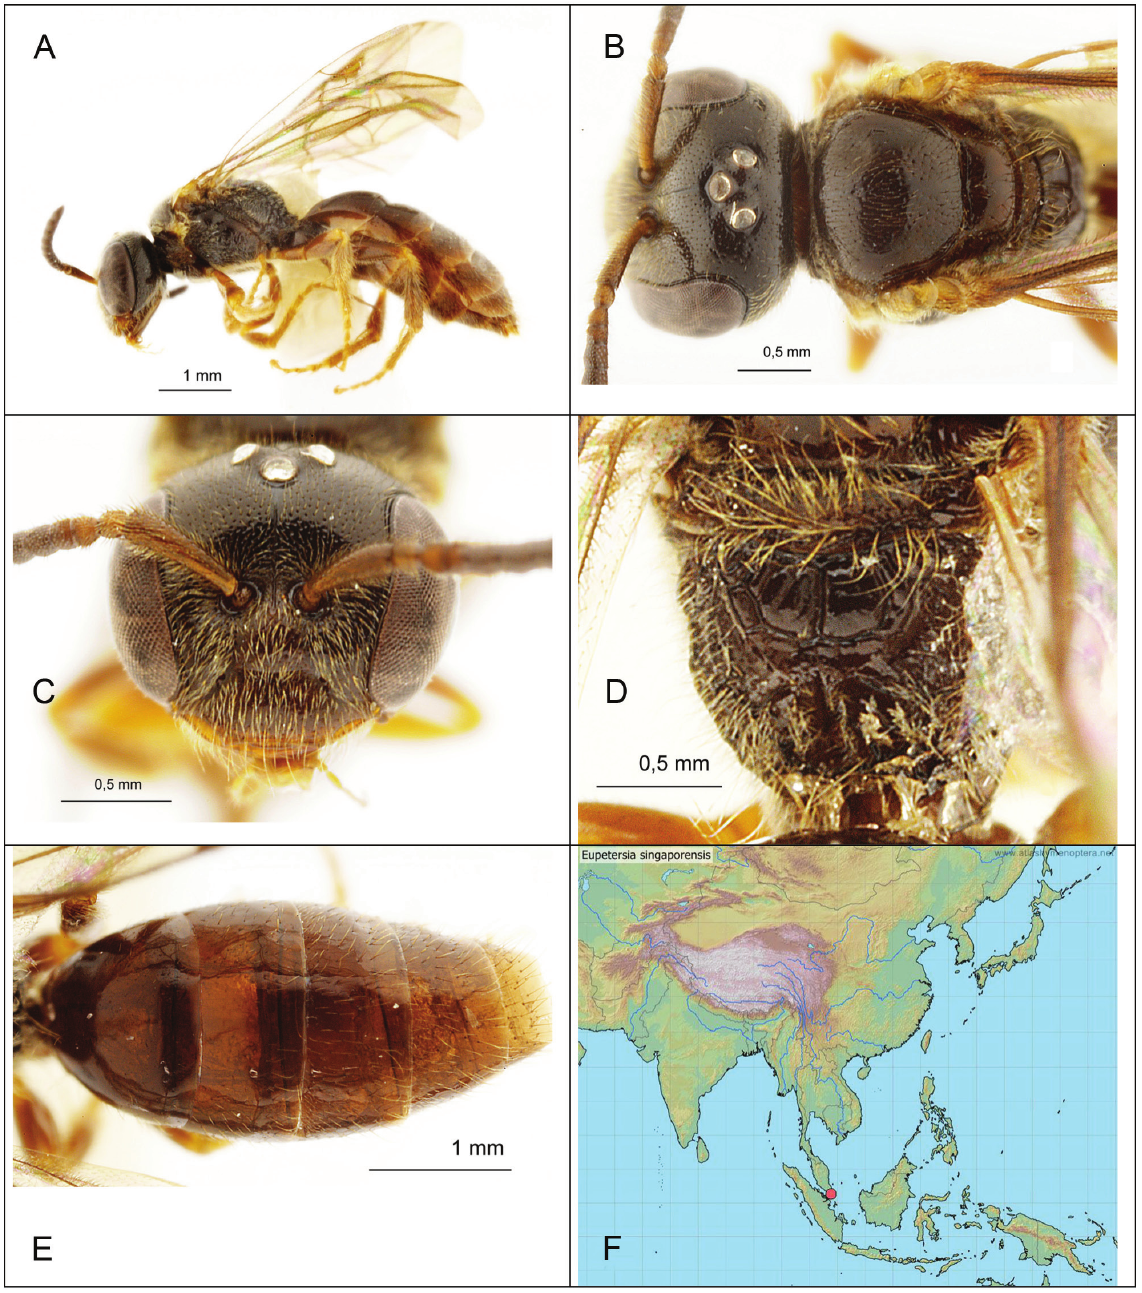
Fig. 1. Eupetersia singaporensis sp. nov., ♂ holotype. A . Lateral habitus. B . Dorsal view of head and mesosoma. C . Facial view. D , Propodeum. E . Metasoma. F . Geographic